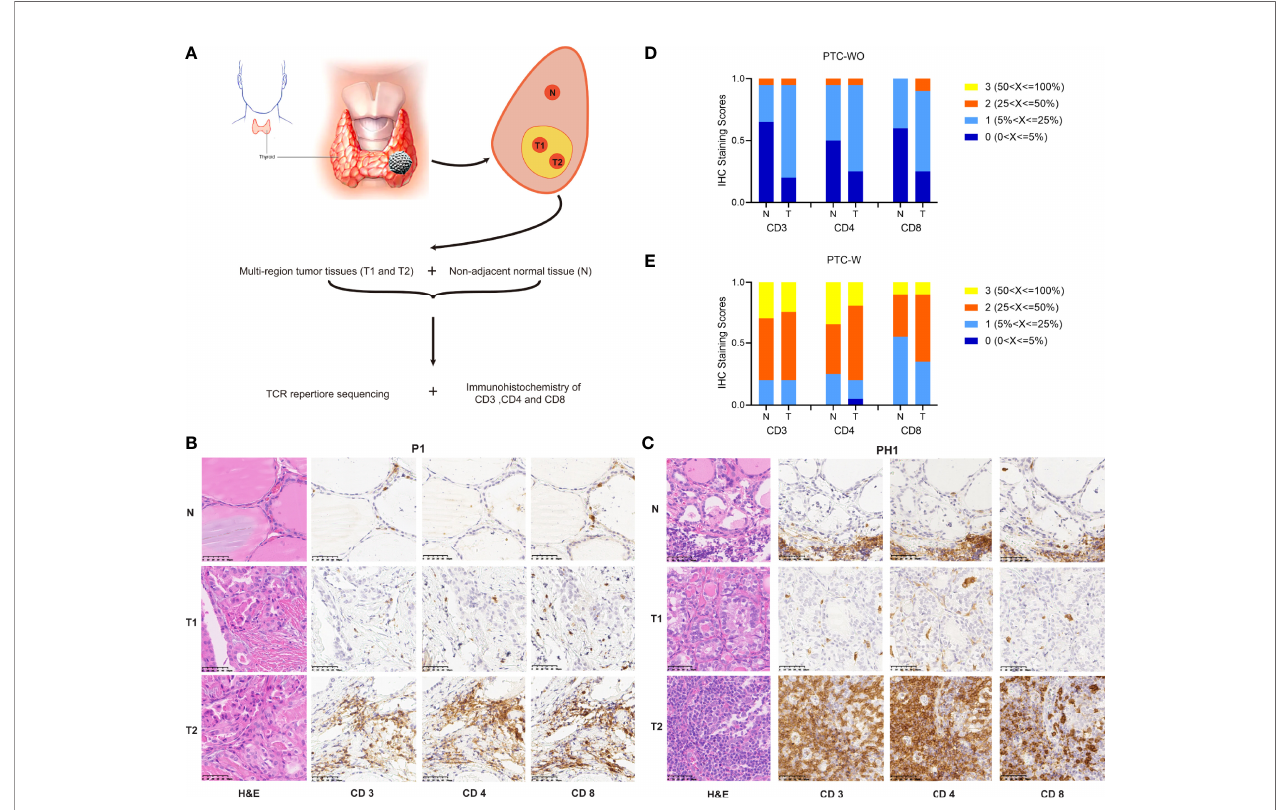
FIGURE 1 | Schematic diagram of sample preparing and comparison of CD3+, CD4+ and CD8+ T cells in PTC with and without HT. (A) Schematic diagram of sample collection. (B, C) Representative H&E and IHC staining images of CD3+ CD4+ and CD8+ T cells in PTC with and without HT (magni fi cation ×400). (D, E) The statistical results of CD3+ CD4+ and CD8+ T cells in PTC with and without